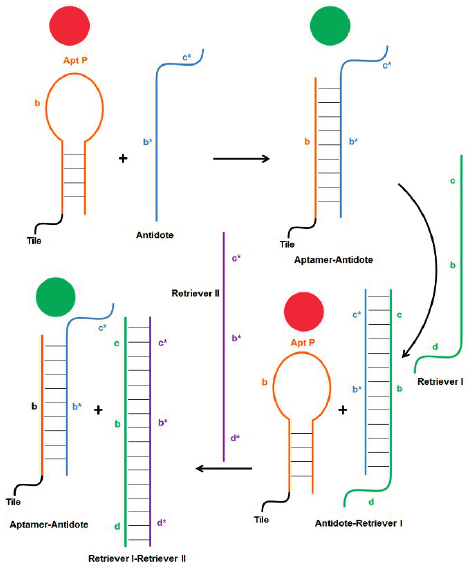
Figure 6. Schematic of regulation cycles. Aptamer turns off the coagulation cascade (red circles), while antidote reverses inhibition and turns on coagulation (green circles). Coagulation can be turned off again by addition of retriever I strand which binds to the overhang in the antidote and displaces the aptamer, which regains its folded structure and inhibits thrombin. Similarly, retriever II strand can displace antidote using the overhang on retriever I. The now free antidote, once again, binds to and deactivates aptamer, turning coagulation back on.